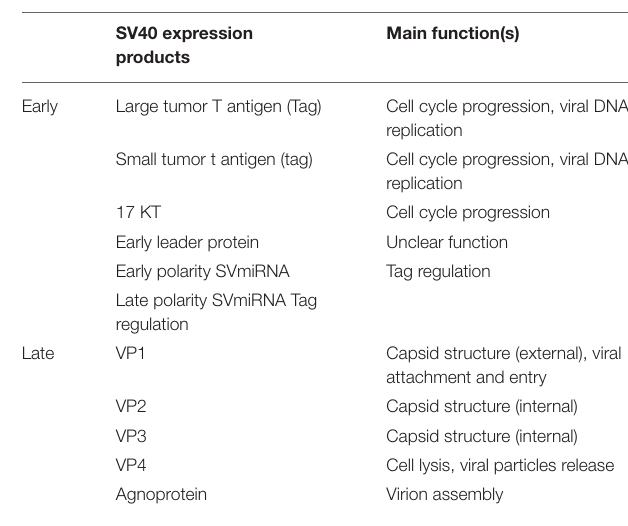
TABLE 1 | SV40 gene